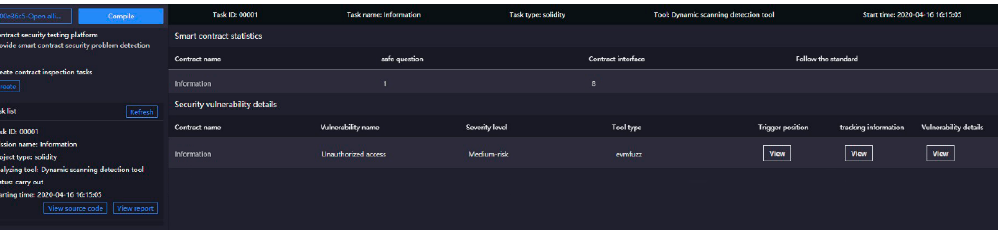
Figure 14. Test results of info smart contract.